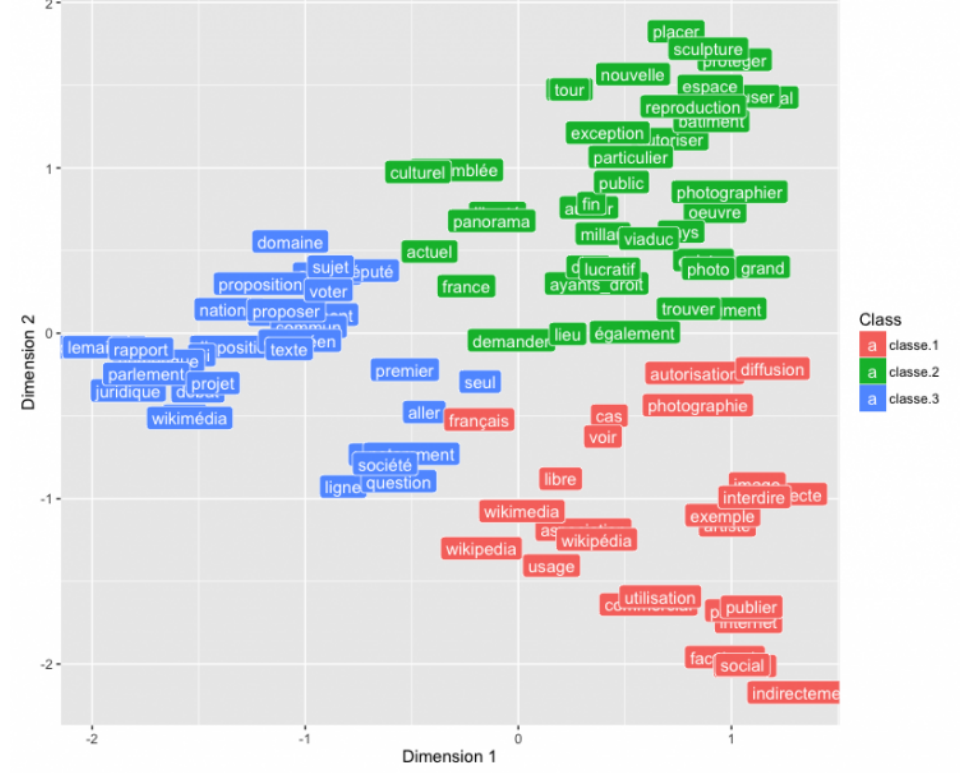
Figure 3: Words and media correspondence in the French